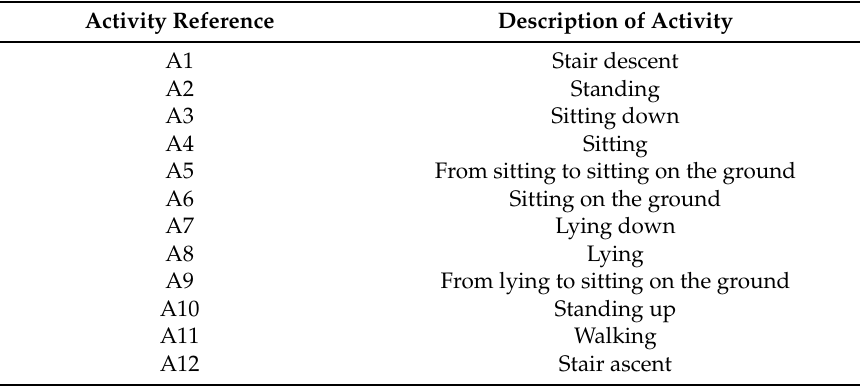
Table 2. List of the selected activities (A1…A12).